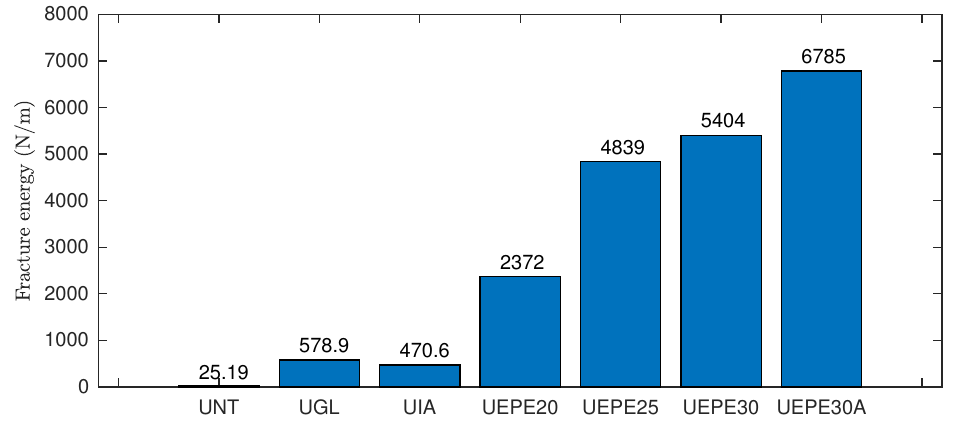
Figure 9. Fracture energy of the specimens.